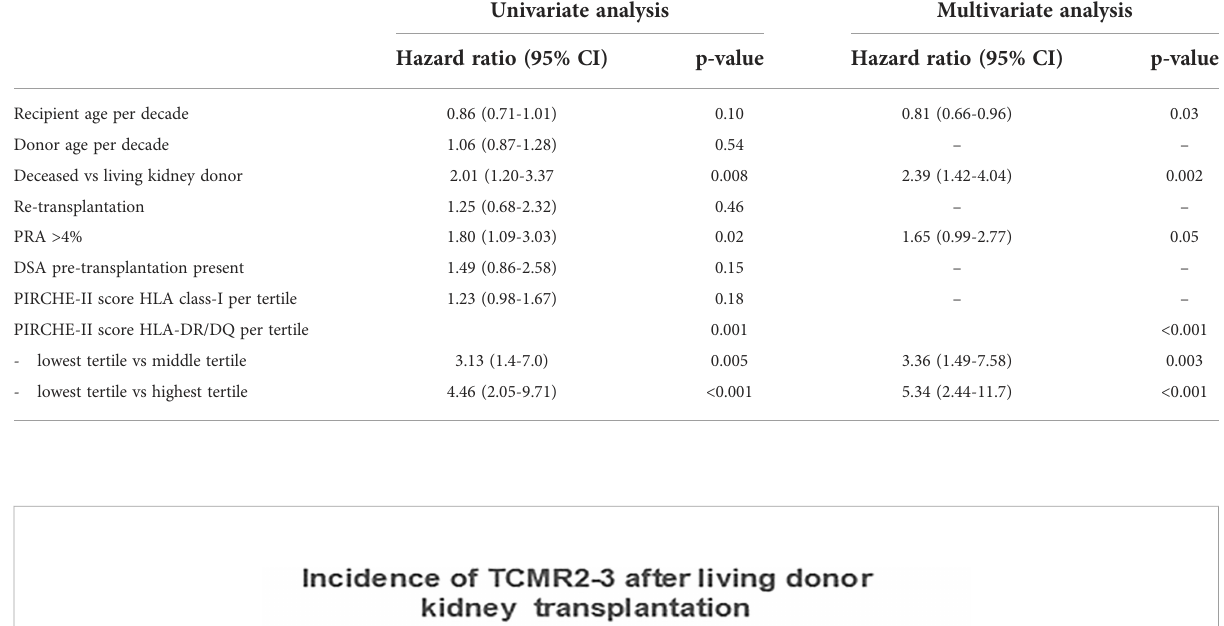
TABLE 3 Uni- and multivariate Cox proportional hazard analysis for T-cell mediated rejection Banff grade